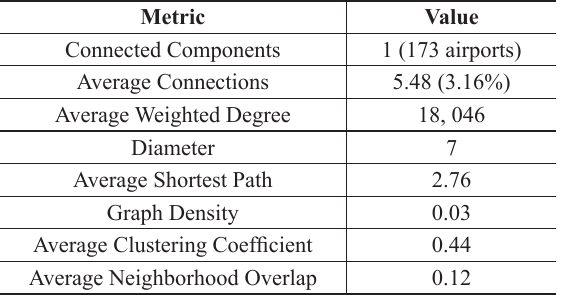
National and International